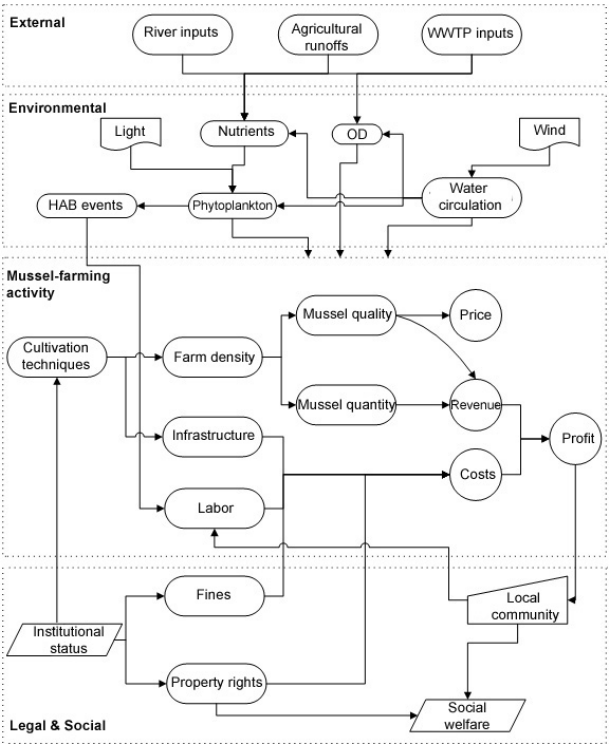
Fig. 2 . Conceptual diagram of the